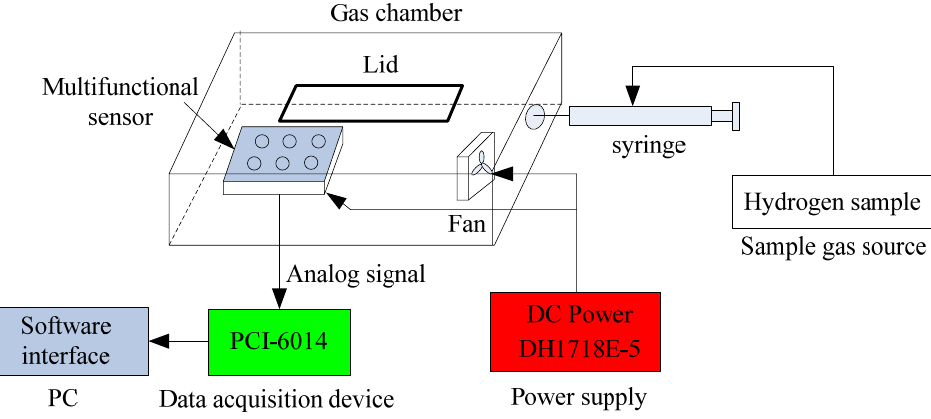
Figure 7. Block diagram of health evaluation experimental system.